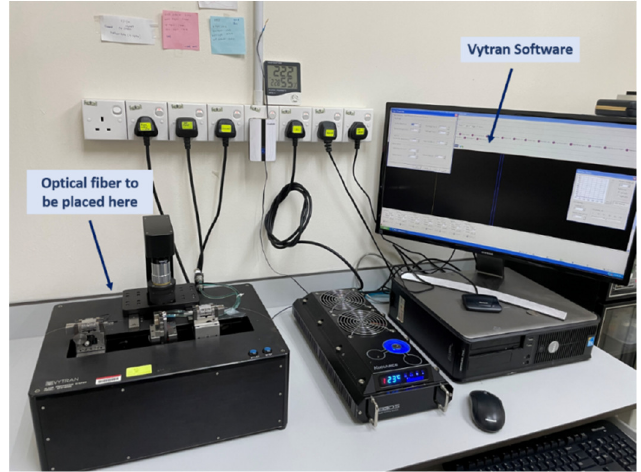
Figure 1. Vytran GPX-3400 glass processing workstation in Photonics Laboratory, Universiti Putra Malaysia (UPM).